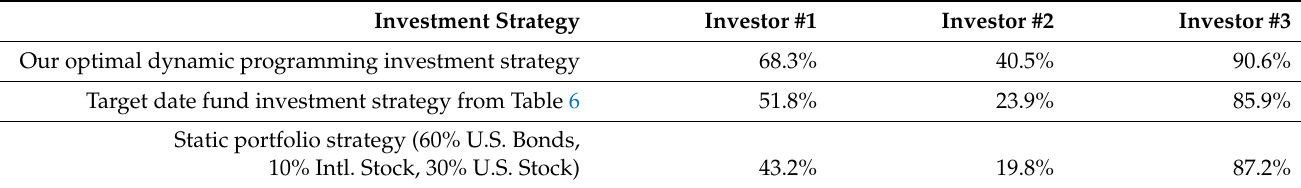
Table 7. The effect of the investment strategy on the optimal probability of solvency. In each of the nine cases shown here, we present the optimal solvency probability after determining and applying the optimal tax strategy. The values of L and γ in the optimal tax strategy are not strongly affected by which investment strategy is selected. Parameter values for Investors #1, #2, and #3 are given in Table 3.